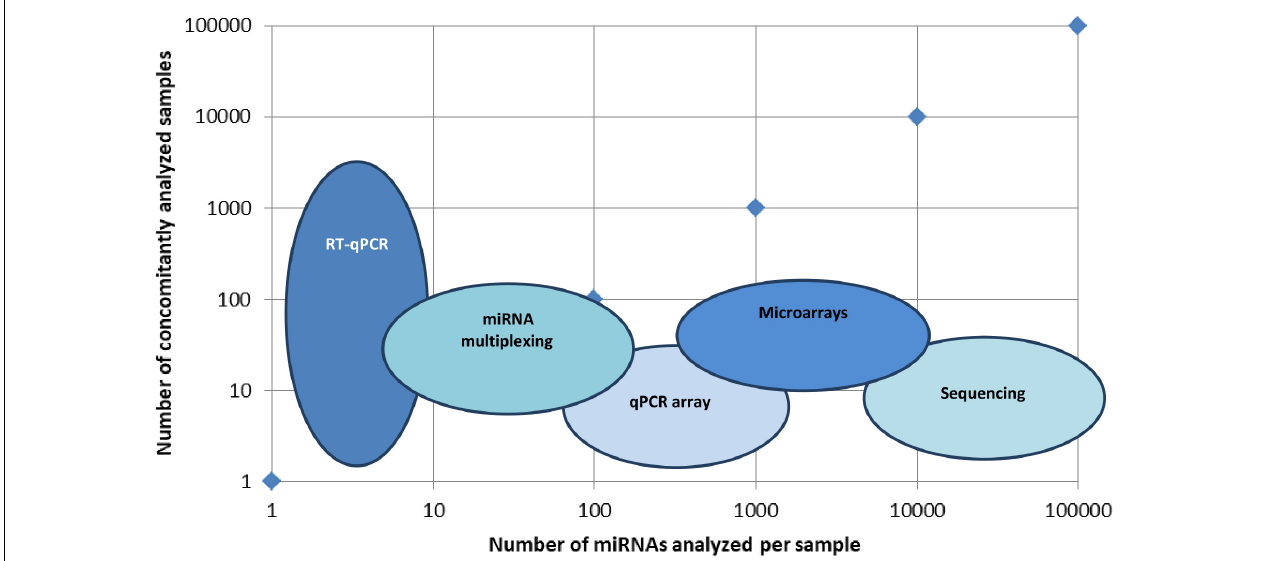
FIGURE 1 | Main technologies used in miRNA identification. Graphical representation of several miRNAs identified per sample versus a number of concomitantly analyzed samples. Technologies like RT-qPCR identify a few types of miRNAs, but in a large set of samples, miRNA multiplexing can identify hundreds of miRNAs in hundreds of different samples, while microarrays and sequencing can identify up to hundreds of thousands of miRNAs in hundreds of different samples. TABLE 1 | Sample type advantages and disadvantages for miRNA identification.